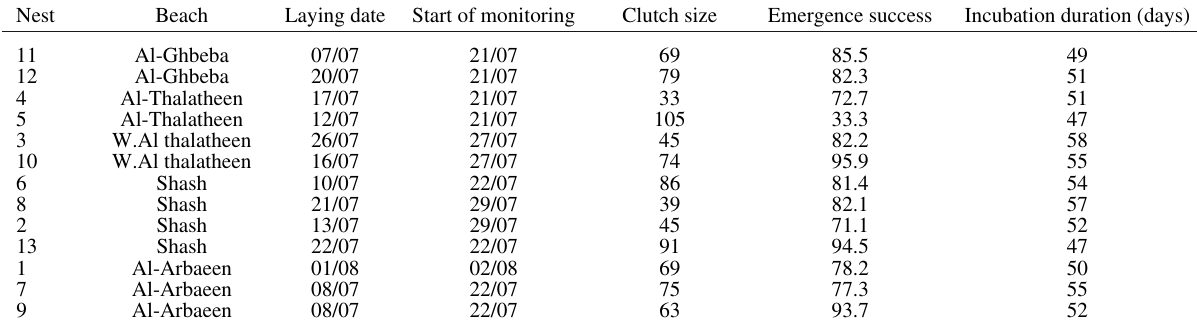
Table 2. – Information on the studied